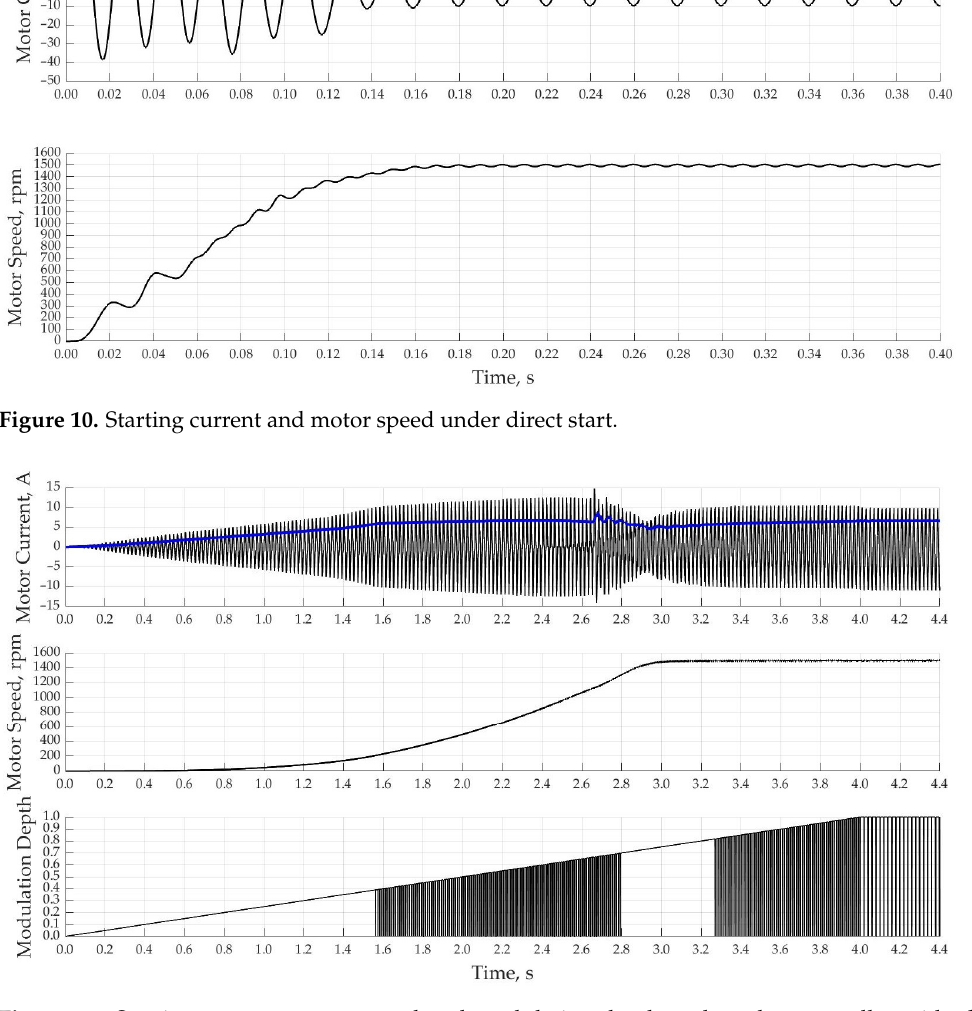
Figure 10. Starting current and motor speed under direct start.